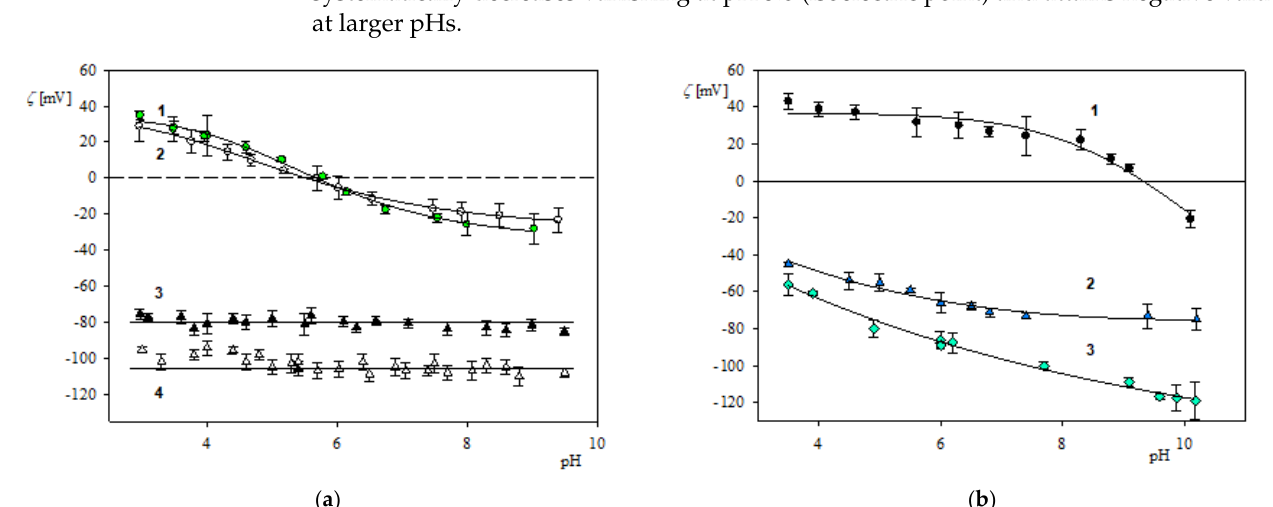
Figure 1. Part ( a ). The dependence of the zeta potential of fibrinogen molecules and LS particles on pH determined by the LDV method. 1—fibrinogen, 0.001 mol L − 1 NaCl, 2—fibrinogen, 0.01 mol L − 1 NaCl, 3—LS particles, 0.001 mol L − 1 NaCl, 4—LS particles, 0.01 mol L − 1 NaCl; Part ( b ). The dependence of the zeta potential of mica on pH determined by the streaming potential method. 1—mica/PLL layer, 0.01 mol L − 1 NaCl, 2—bare mica, 0.01 mol L − 1 NaCl, 3—bare mica, 0.001 mol L − 1 NaCl. The solid lines represent fits of experimental data.